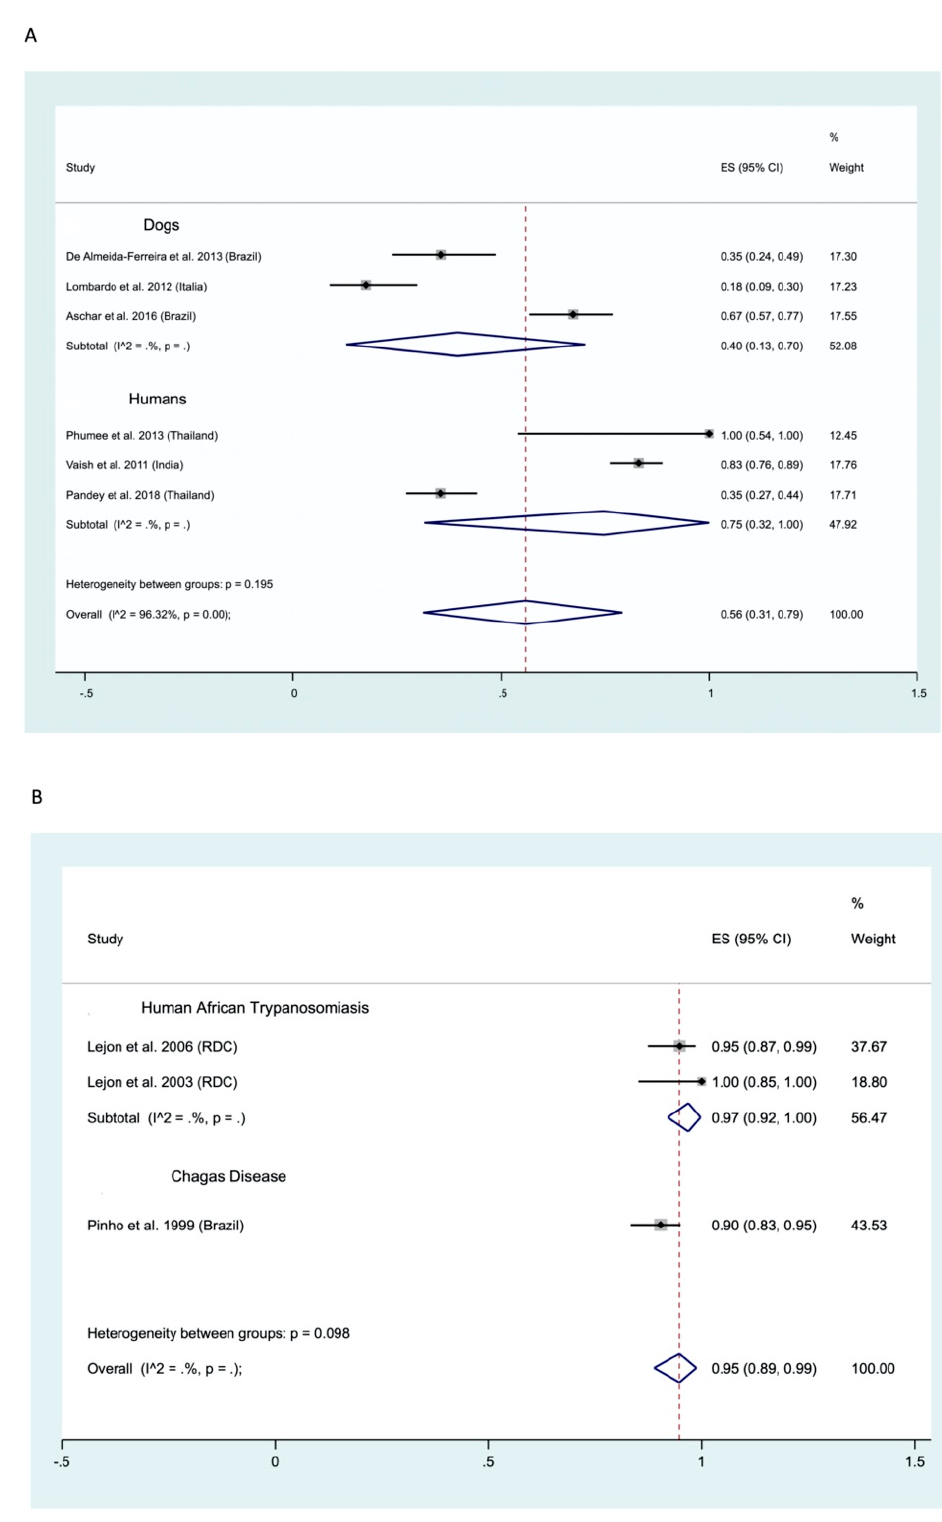
Figure 7. Forest plot representation of the extracted data for saliva analysis using molecular detection methods for human leishmaniases ( A ) and antibody detection methods with subgroup analysis for human African trypanosomiasis and Chagas disease ( B ).